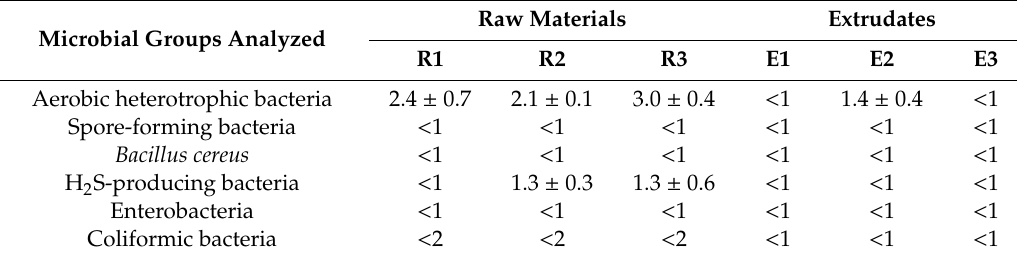
Table 2. Microbiological quality of the raw materials (R1–R3) and extruded food samples (E1–E3) presented as Log colony forming units per gram.